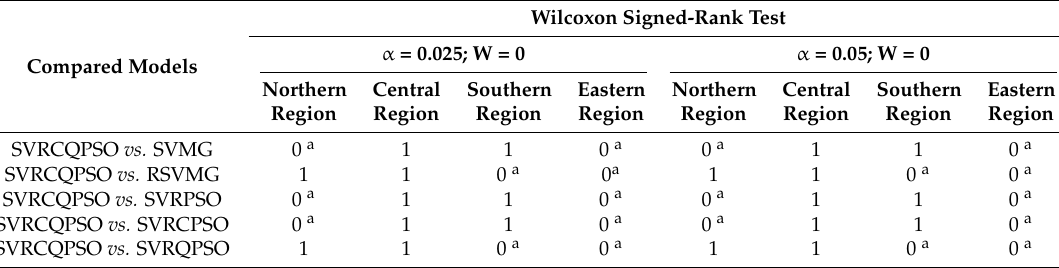
Table 3. Wilcoxon signed-rank test (example one).